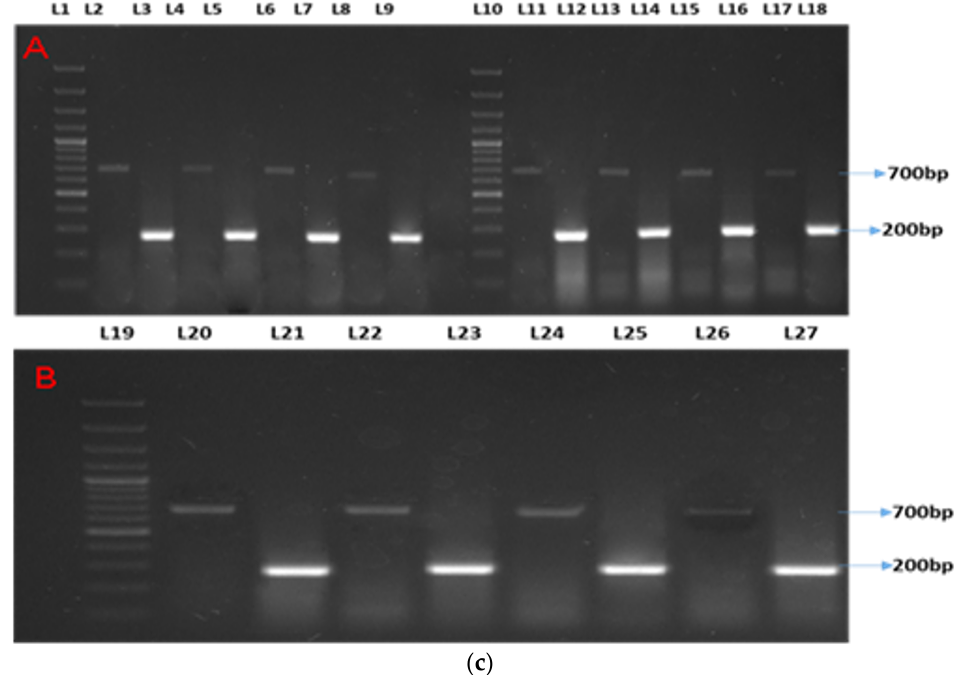
Figure 1. ( a – c ) show the semi-quantitative PCR of targeted genes and housekeeping genes. Legends. ( a ) Showing semi-quantitative PCR of ISG15. ( b ) Showing semi-quantitative PCR of Mx gene. ( c ) Showing semi-quantitative PCR of STAT1 gene. L-1, 11, and 19: 1Kb molecular marker; L-2, 4, 6, 8, 11,13, 15, 17, 20, 22, 24, and 26: β -actin (housekeeping gene); L-3: CT90; L-5: T1-90; L-7: T2-90; L-9: T3-90; L-12: CT100-Ah; L-14: T1-100Ah; L-16: T2-100Ah; L-18: T3-100Ah; L-21: CT100-Et; L-23: T1-100Et; L-25: T2-100Et; L-27: T3-100Et.